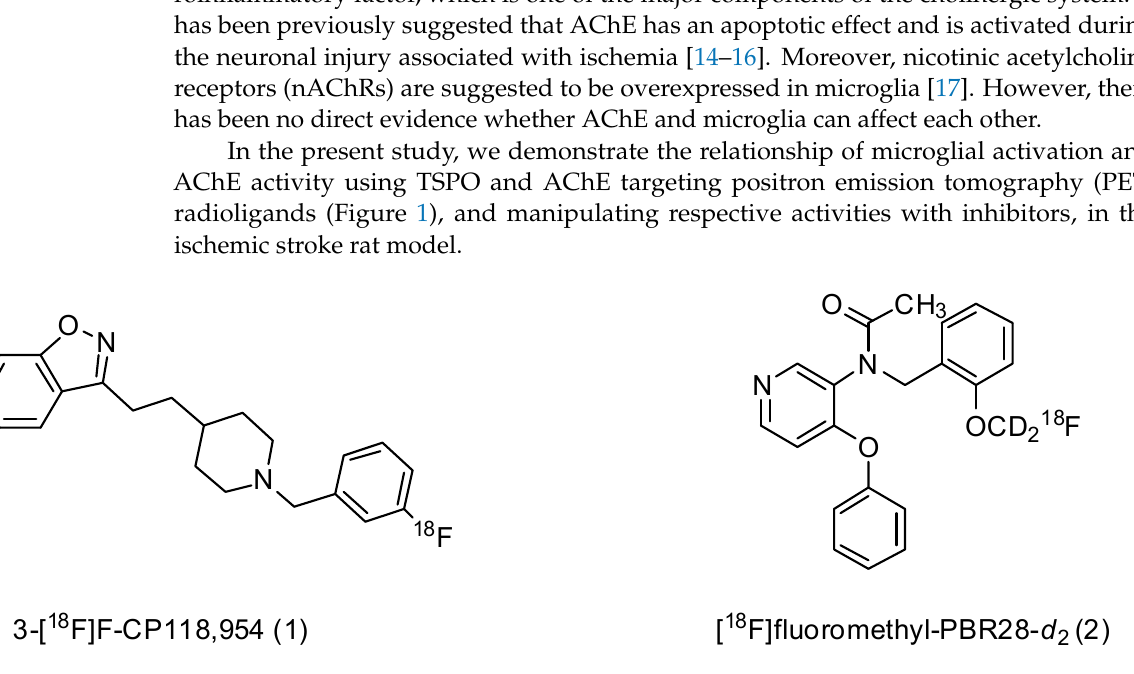
Figure 1. Structures of AChE-binding ( 1 ) and TSPO-binding ( 2 )